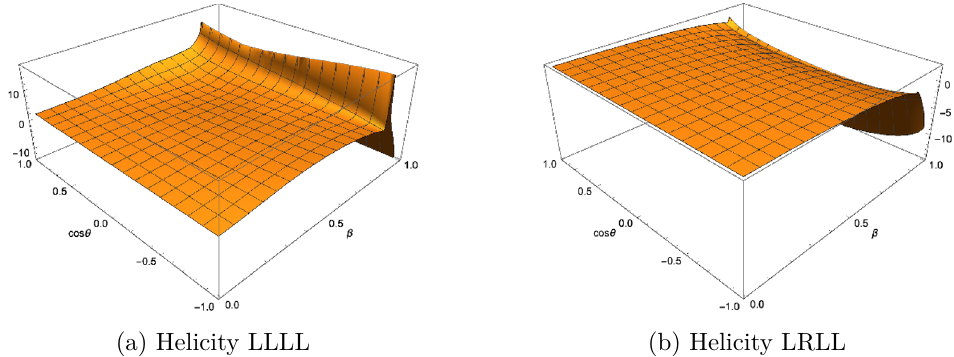
Figure 9. Finite remainder of the vector-vector and axial-axial part of the two-loop, leading colour ( N C ), helicity amplitudes interfered and normalised by the leading order amplitude, see eq. (5.9). We set the renormalisation scale µ = 2 m W .